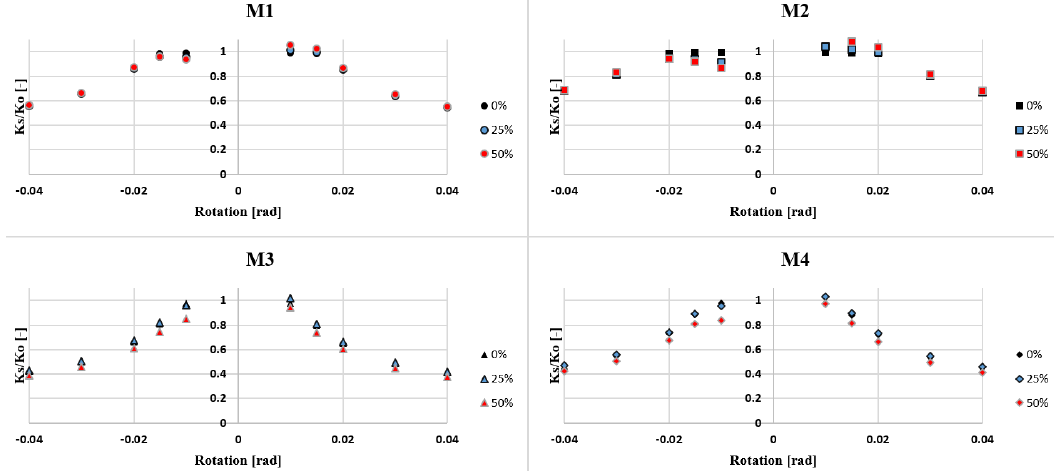
Metals 2020 , 10 , x FOR PEER REVIEW Figure 8. Normalized secant sti ff ness vs. rotation for the configurations studied. Figure 8. Normalized secant stiffness vs. rotation for the configurations studied. Figure 8. Normalized secant stiffness vs. rotation for the configurations studied.